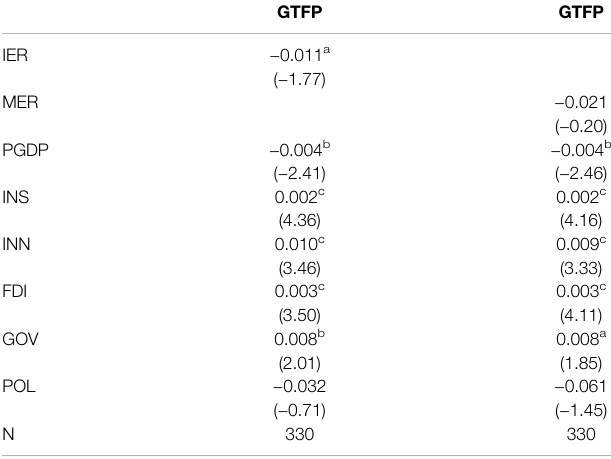
TABLE 6 | Results of Lasso